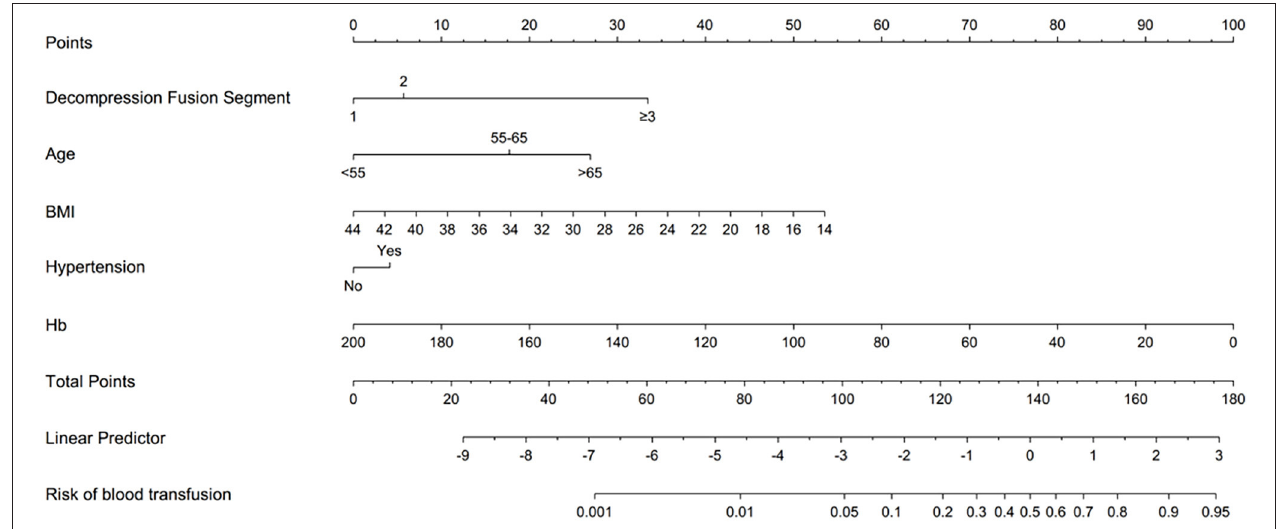
FIGURE 1 | A nomogram based on independent risk factors for predicting transfusion